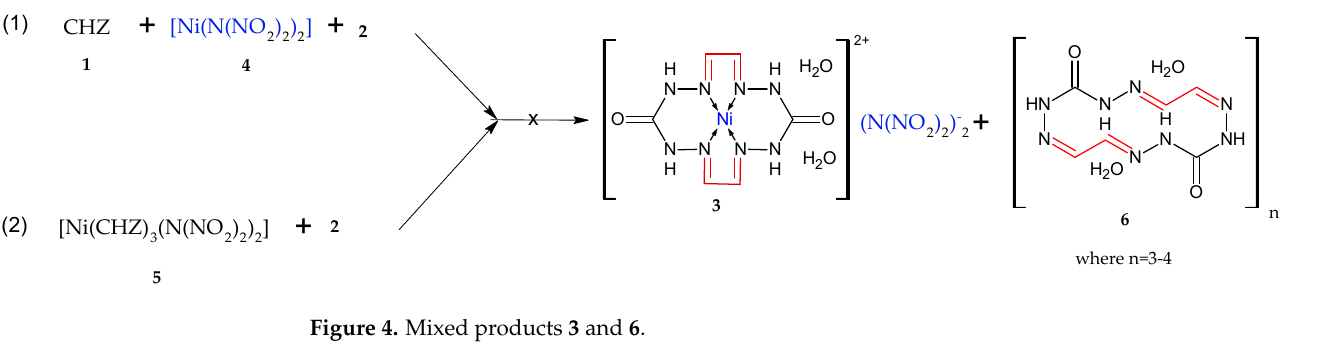
Figure 3. Synthesis of adducts 7 and 8. Alternatively, this can be represented as mixed products of macrocycle 3 with monocycle 6 (Figure 4).